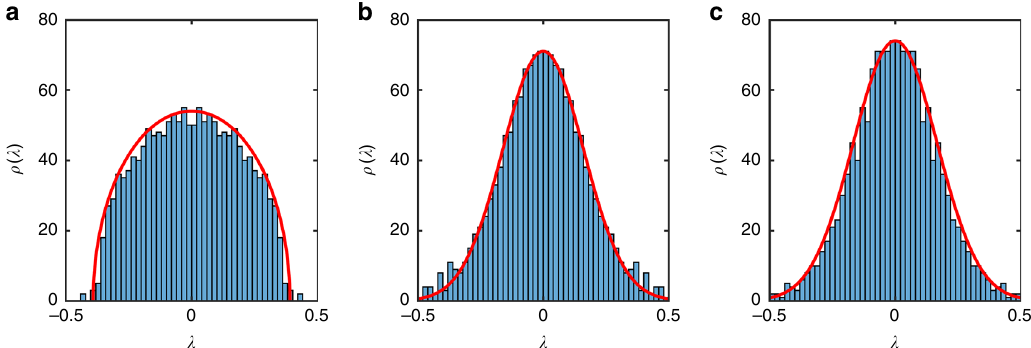
Fig. 7 Lyapunov Spectrum for a thermo fi eld MPS respresentation of Ising model dynamics. a Non-integrable case with J = 1, h x = 0.5, h z = 1. b Integrable case with J = 1, h x = 0.5, h z = 0. c Nearly integrable case with J = 1, h x = 0.5, h z = 0.1. In all cases, the spectrum is obtained for a wavefunction MPS at bond order D ¼ 16. The non-integrable case appears to fi t a semi-circle distribution with radius r = 0.39, the integrable case appears to be Gaussian with standard deviation σ = 0.167 and the nearly integrable case appears to be Gaussian with standard deviation σ = 0.161